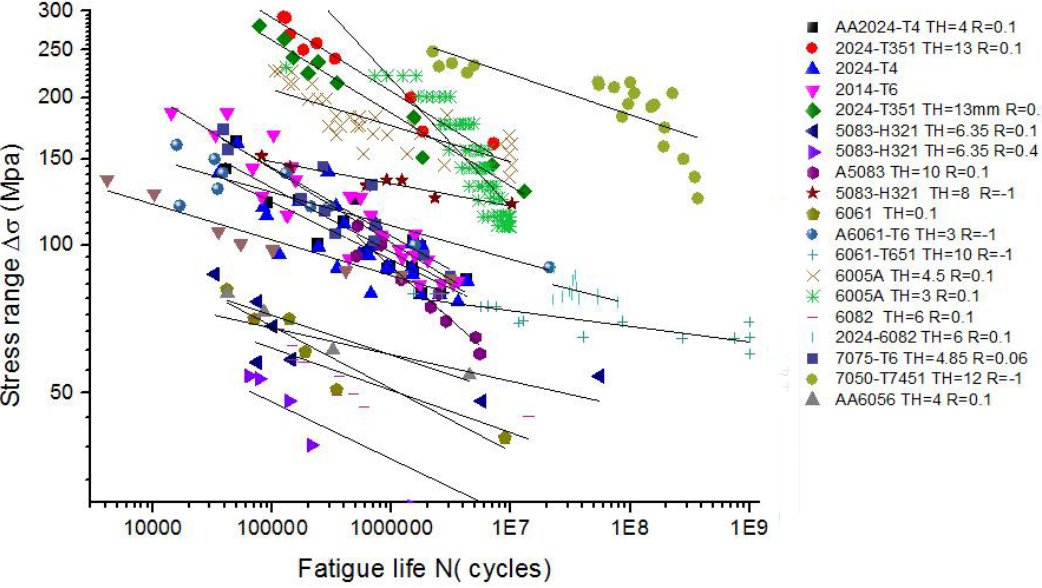
Figure 14. S–N curve for some materials [23,25,32,55,65].